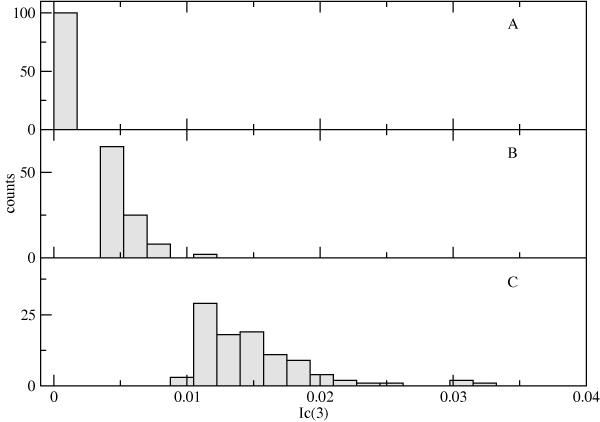
Distribution of the 100 largest  values for the PI0 (A), PI1 (B), and PI2+ (C) cohorts.